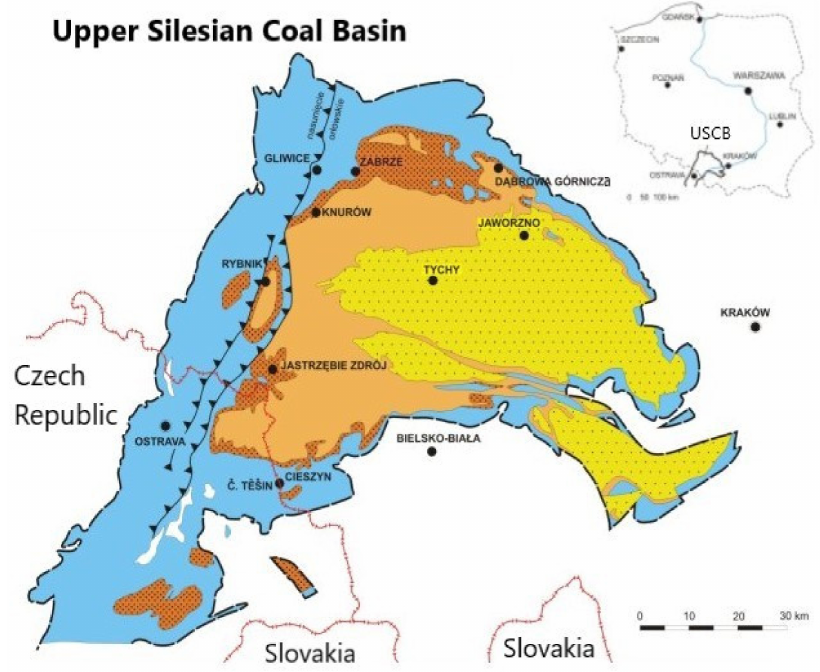
Figure 1. Location of the Upper Silesian Coal Basin study area [41–43]